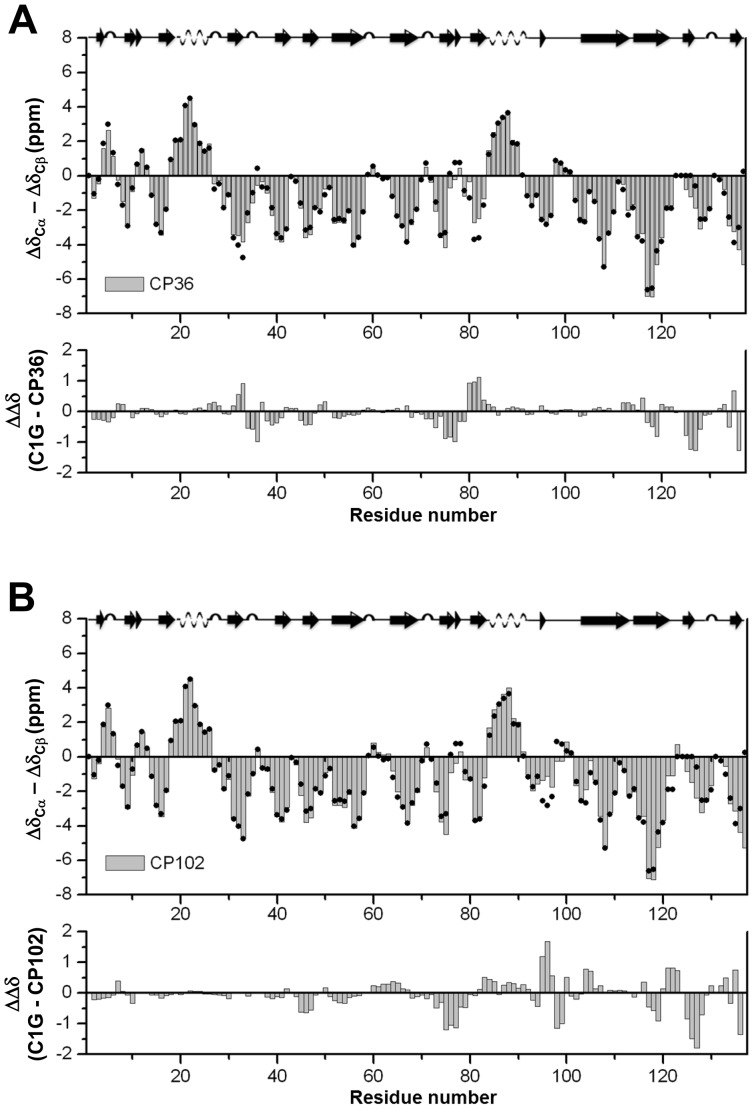
Secondary structure of the CP variants (A) CP36 and (B) CP102, evaluated according to the parameter ΔδCα−ΔδCβ.The chemical shift values for 13Cα and 13Cβ of CP36 and CP102 were obtained, and ΔδCα and ΔδCβ were calculated from the differences between the experimental values and random coil values. The value of ΔδCα−ΔδCβ for each residue represents the average of three consecutive residues, centered at the particular residue. The ΔδCα−ΔδCβ value derived from native NpuInt C1G (indicated by closed circles) is overlaid onto the CP results for comparison. The corresponding secondary structure of C1G is depicted at the top. The difference (ΔΔδ) in (ΔδCα−ΔδCβ) between each CP variant and C1G was calculated and is indicated at the bottom of the figure.